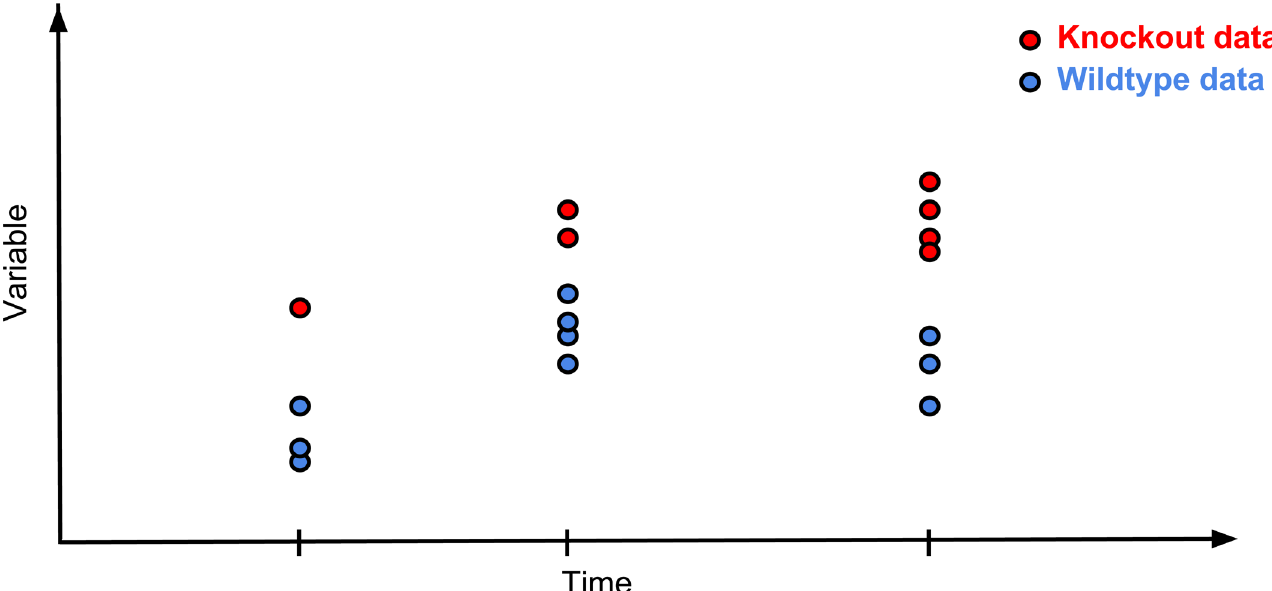
Fig 2. Graphical representation of a typical Time Fixed Effect data structure. The Time as a Fixed Effect analysis requires a data structure where there are multiple batches but each batch has concurrent controls.